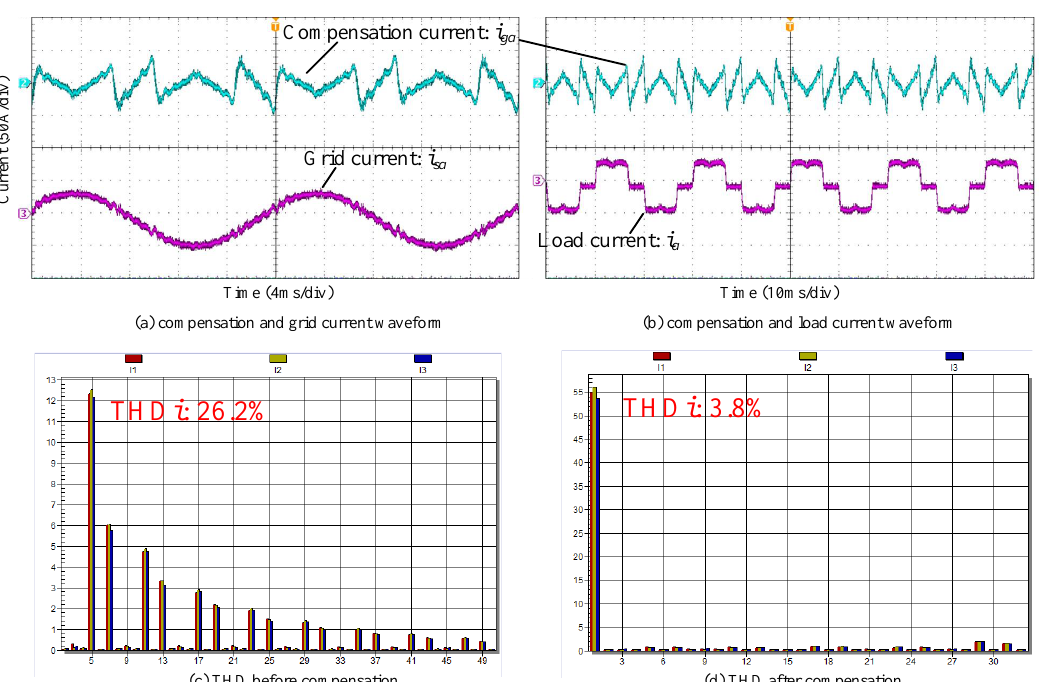
Figure 23. Harmonic compensation waveforms: ( a ) compensation and grid current waveform; ( b ) compensation and road current waveform; ( c ) THDbefore compensation; ( d ) THD after compensation.